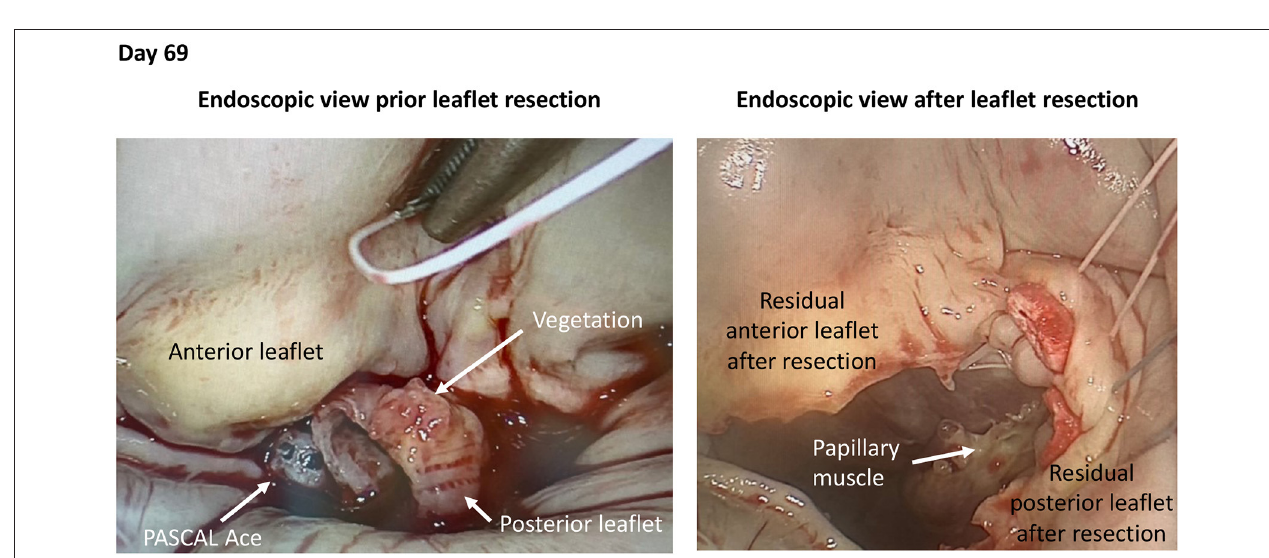
FIGURE 4 | Intraoperative views of PASCAL Ace infective endocarditis. Intraoperative pictures during endoscopic mitral valve repair in infective endocarditis of a PASCAL ACE device.